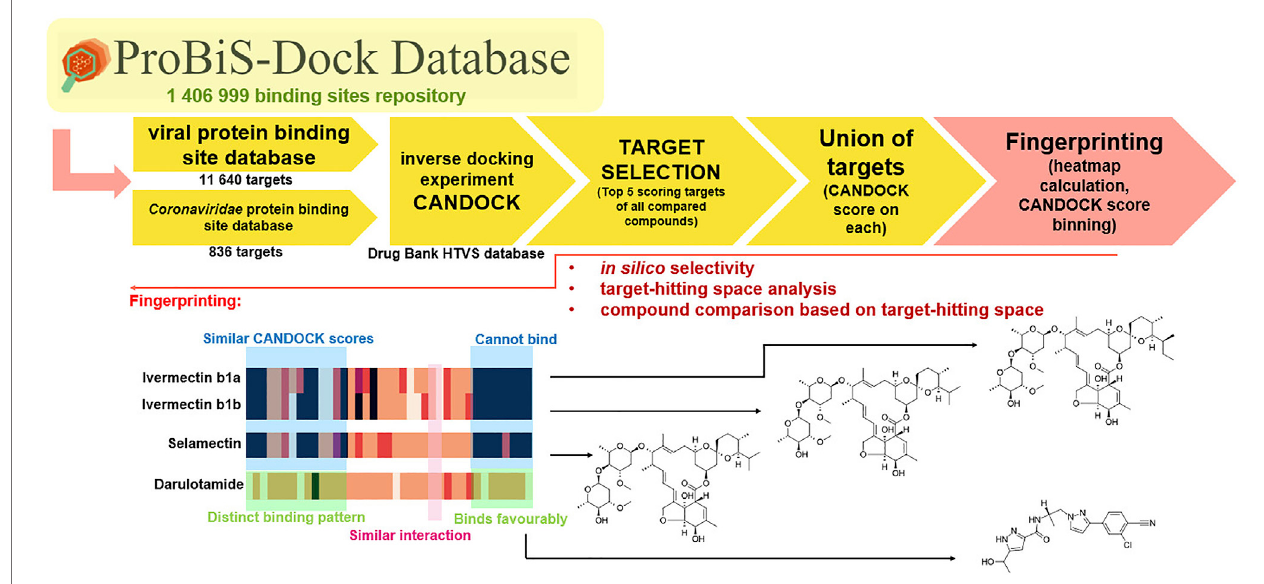
FIGURE3| Inversedocking fi ngerprintingprotocolandexampleof fi ngerprintcomparison.Fingerprintingusingheatmapsisusefulfordeterminingthesimilarbinding patterns and fi nd targets where compounds bind favorably. The darker the color in the fi ngerprint heatmaps, the less favorable the binding of the compound into target.